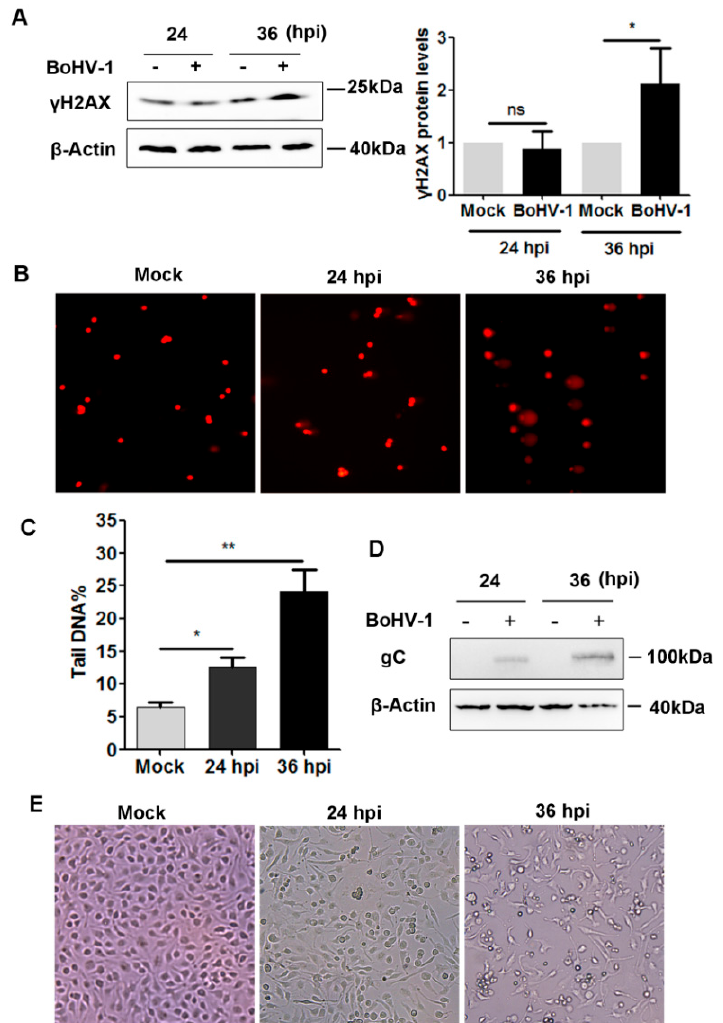
Figure 1. Assessment of γ H2AX protein levels as an indicator of BoHV-1 infection-induced DNA damage in A549 cells. ( A , D ) Confluent A549 cells in 60 mm dishes were mock-infected or infected with BoHV-1 at an MOI of 0.1 for 24 and 36 h. The cell lysates were prepared and subjected to Western blot analysis to detect the protein levels of γ H2AX ( A ) and viral protein gC ( D ). In parallel, β -Actin was tested in the same gel to indicate protein loading. The relative band intensity was analyzed with ImageJ software. The band intensity of γ H2AX was initially normalized to β -Actin, and the fold change after infection was calculated by comparison with the uninfected control that was arbitrarily set as 1. Images represent data from three independent experiments. Data shown in the right panel of ( A ) are the means ± SD of the three independent experiments. Statistical analyses were performed using Student’s t -test (ns, not significant; * p < 0.05). ( B , C , E ) A549 cells were infected with BoHV-1 (MOI = 0.1) for 24 and 36 hpi. The cells were photographed to compare the effect of virus-induced cytotoxicity to uninfected cells ( E ). Then the cells were collected and subjected to comet assays ( B ). Images represent data of three independent experiments (magnification × 200). Three hundred cells were randomly selected from individual samples for the analysis of TailDNA% with CASP software. Data shown are the means ± SD of the three independent experiments. Statistical analyses were performed using Student’s t -test (* p < 0.05, ** p < 0.01).